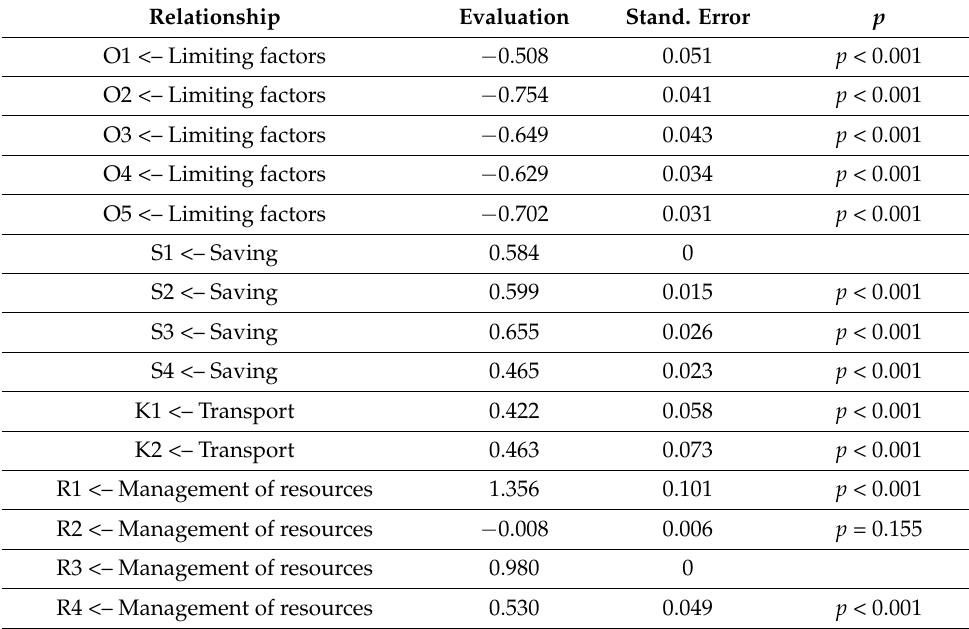
Figure 5. Estimated model of factors limiting pro-ecological behavior (Model II). Table 12. Estimated parameters of the factor analysis (Model II).